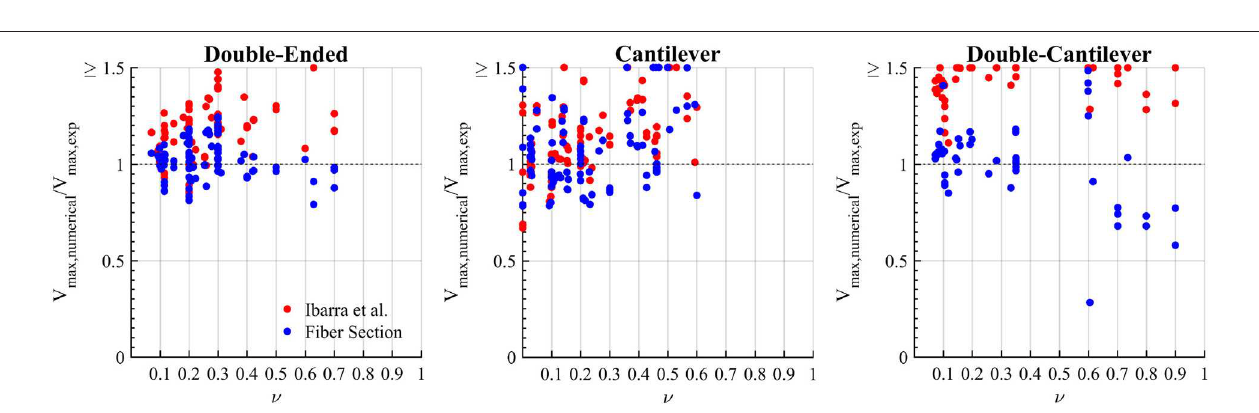
FIGURE 9 | Experimental Shear vs. Numerical Shear for different test